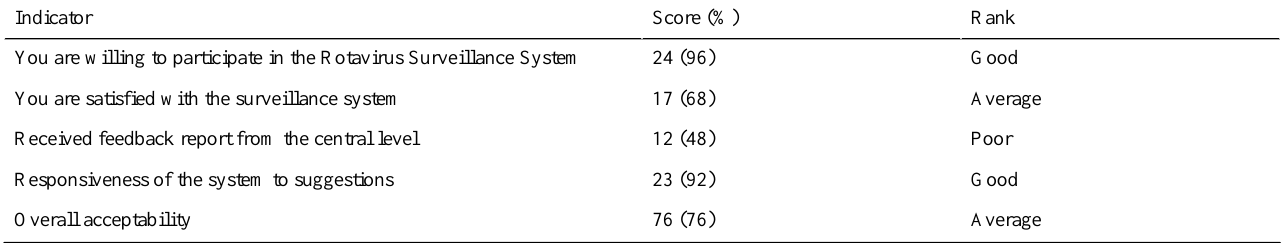
Table 5. The scores (score percent, %) and rank of the acceptability indicators as assessed by the sentinel site coordinators.